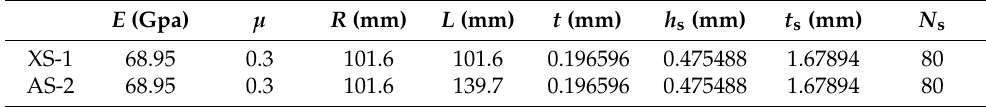
Table 2. Geometric and material properties of stringer-stiffened